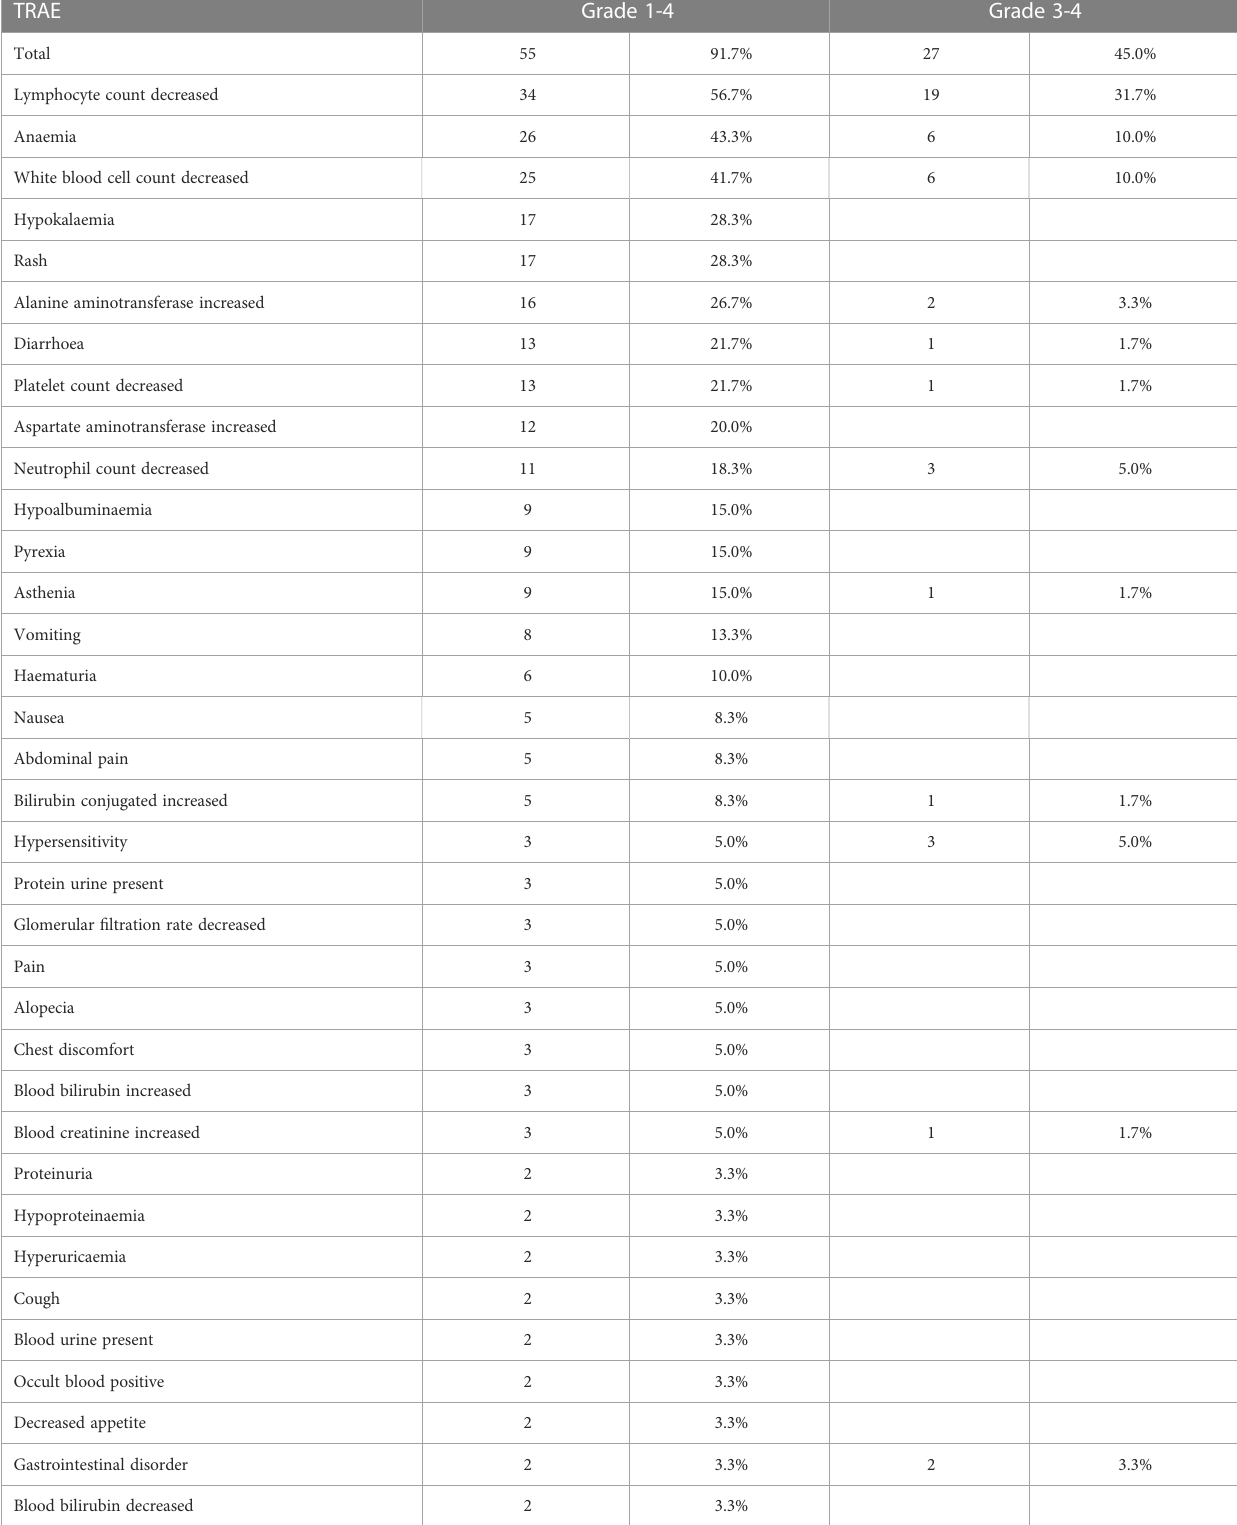
TABLE 4 Treatment related adverse